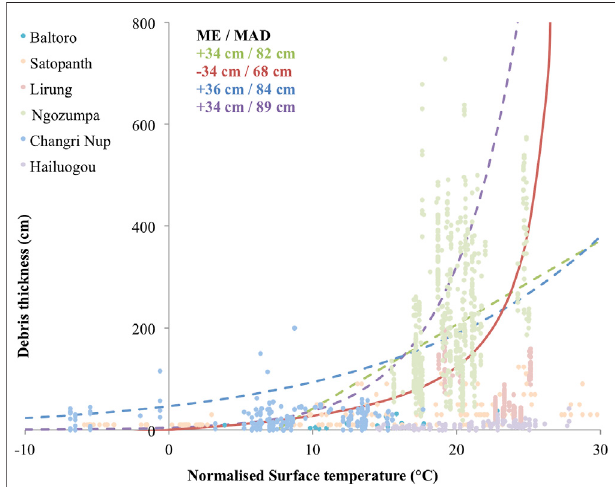
FIGURE 6 | Comparison of the errors of the linear relationship (green), rationalcurve(red),exponential(M)(blue),andexponential(K)(purple)formsof the relationship between debris thickness and surface temperature for the collated dataset from all six glaciers. The solid line indicates the chosen form of the